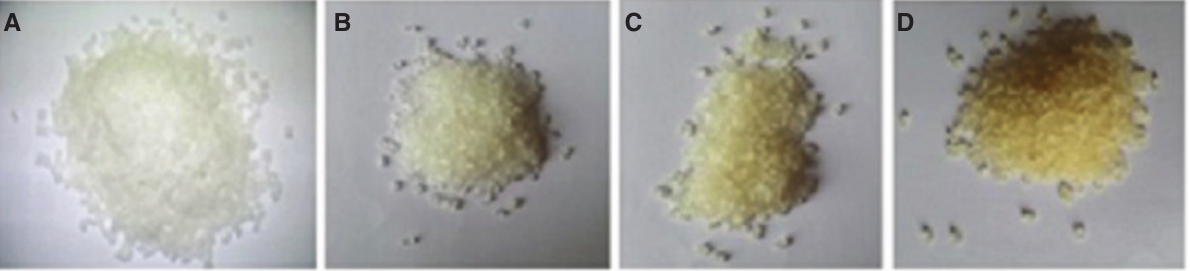
Figure 1: Polypropylene granules containing (A) 0 wt%, (B) 0.3 wt%, (C) 0.8 wt%, and (D) 1.4 wt% treated jute